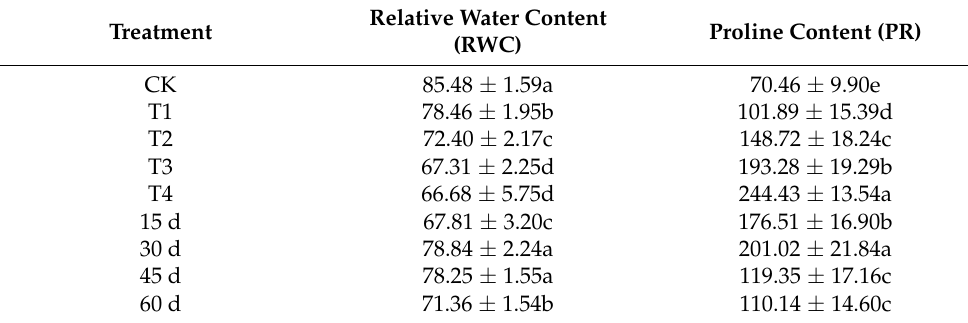
Table 1. The effects of different water stress treatments on RWC and proline content of Glycyrrhiza uralensis . Note: Different lowercase letters indicate a significant difference among treatments or times at a 5% level.